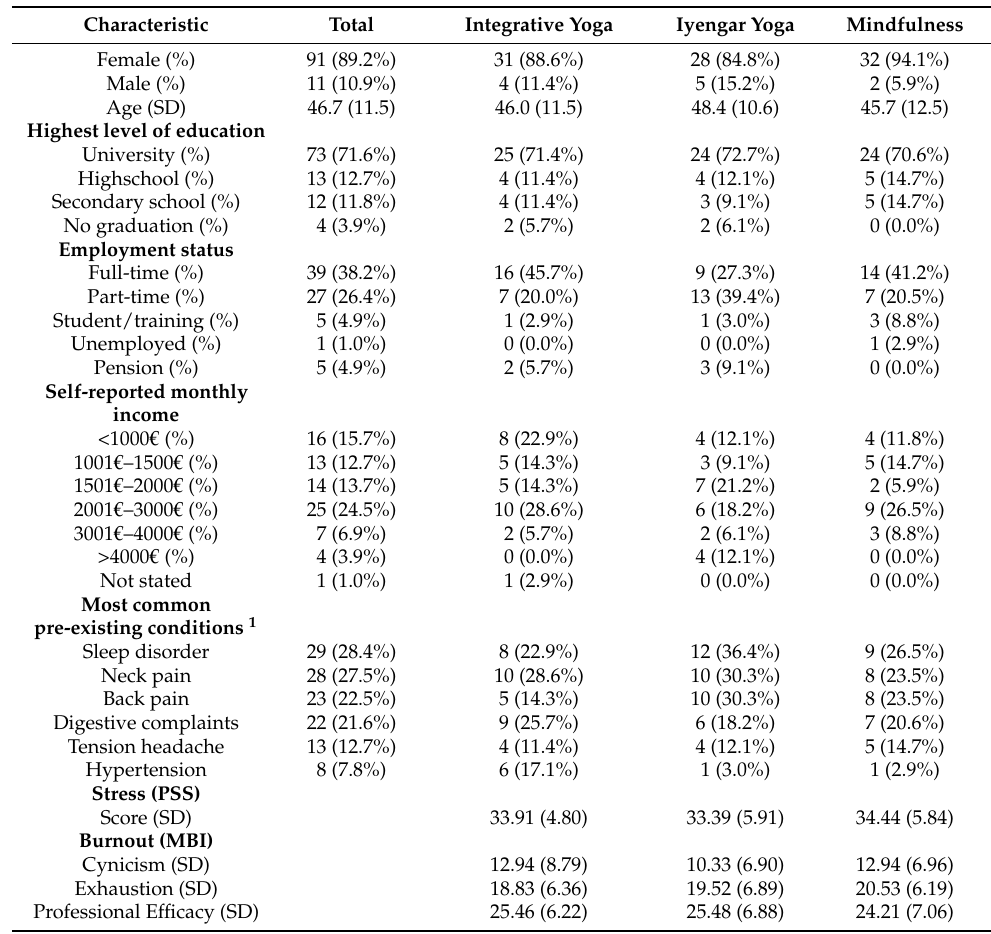
Table 2. Baseline